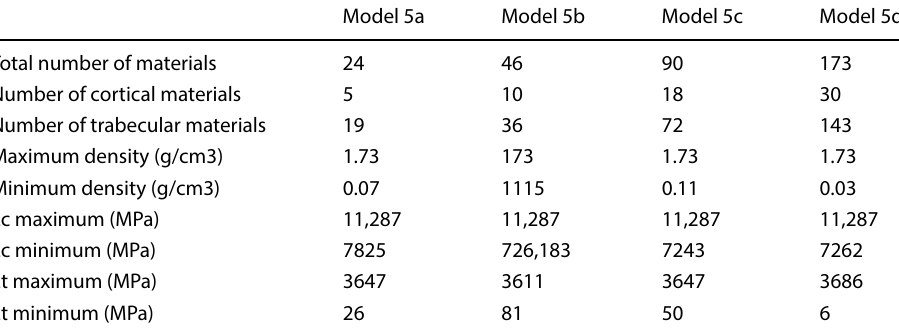
Table 1 Characteristics of the models, Femur No.